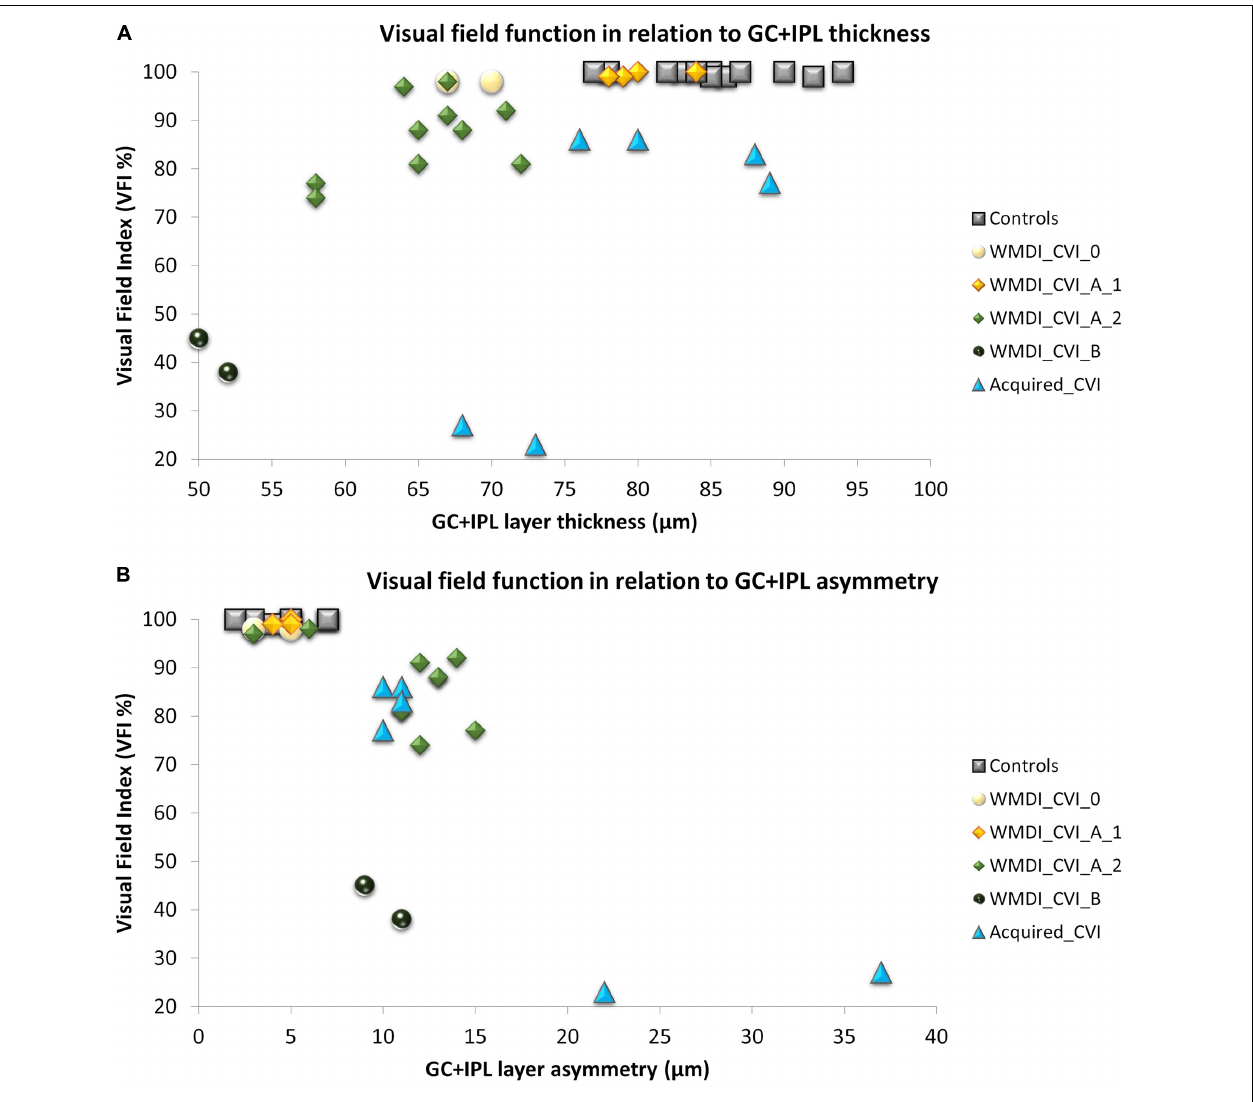
FIGURE 2 | (A) A strong association was seen between retinal structure and function in patients with WMDI. In relation to the range of controls, one WMDI without CVI showed a thin GC+IPL, all grouped as A1 had normal GC+IPL. All subjects in A2 had a thin GC+IPL. Among the three subjects with acquired CVI, one subjects had a thin GC+IPL. (B) All subjects with GC+IPL asymmetry had reduced VF sensitivity. CVI subgroups A1 was separated from A2 and B by GC+IPL asymmetry in all but one case graded with A2 who did not have any VF defect or GC+IPL asymmetry. WMDI, white matter damage of immaturity; CVI, cerebral visual impairment; CVI A1, A2, and B are subgroups of CVI severity according to Sakki et al. (2021) “Acquired” includes subjects with CVI due to brain injury after 18 months of age. GC+IPL, ganglion cell + inner plexiform